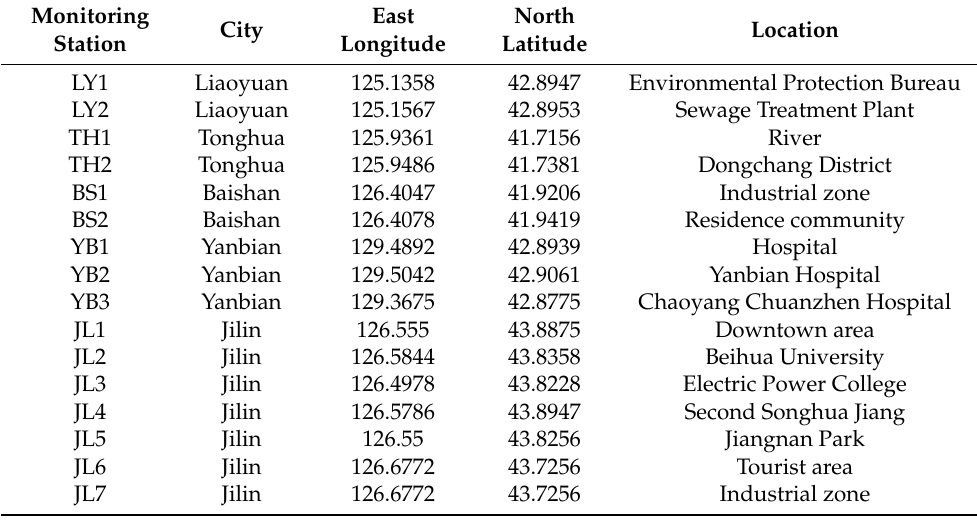
Figure 1. Air quality inspection station in eastern Jilin Province. Table 2. Specific information regarding monitoring stations.